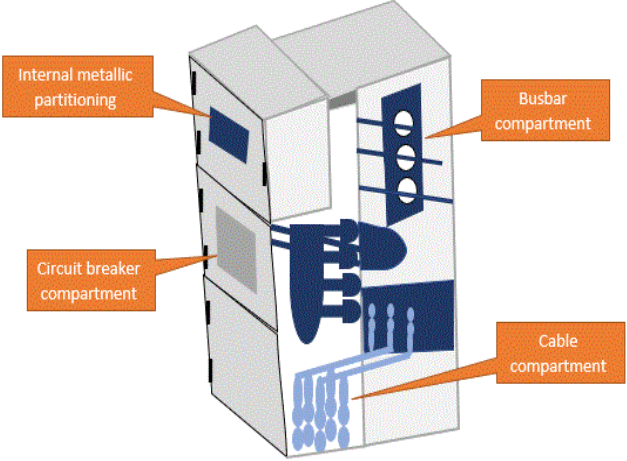
Figure 2. A panel of medium-voltage switchgear.